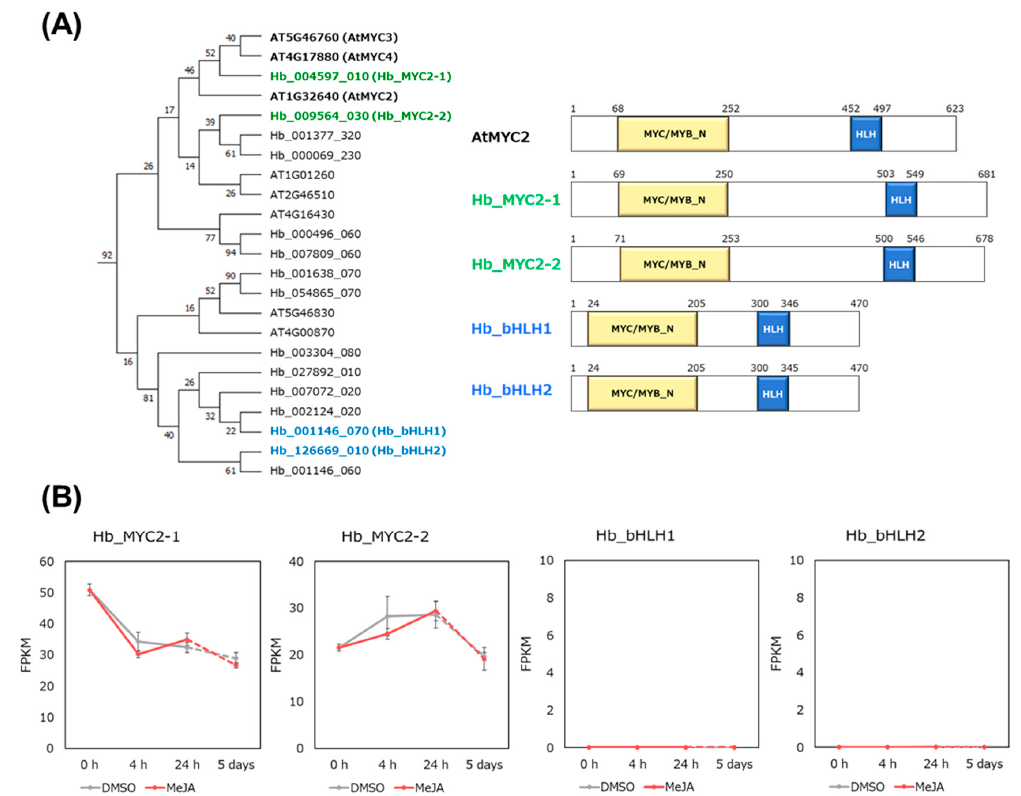
Figure 3. Characterization of four bHLH-type transcription factors (TFs), Hb_MYC2-1, Hb_MYC2-2, Hb_bHLH1, and Hb_bHLH2. ( A ) Phylogenetic tree of MYC2-related bHLH TFs from Arabidopsis thaliana and Hevea brasiliensis and the domain structures of four Hb_bHLH TFs. ( B ) Expression profiles of four bHLH TFs in time-course RNA-seq analysis upon MeJA or DMSO treatment.